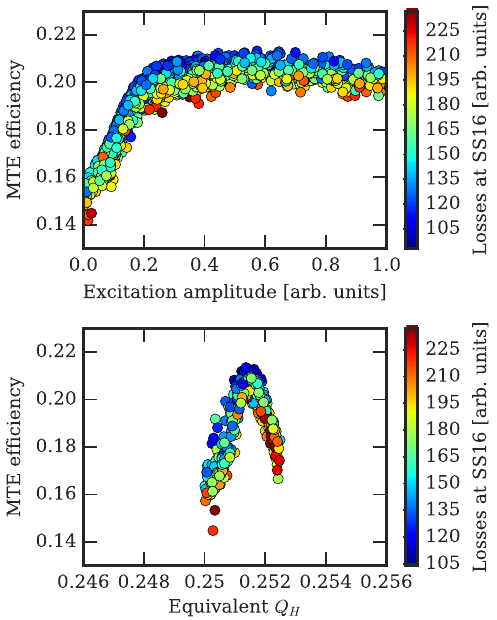
FIG. 14. Dependence of η on the timing (top) and duration MTE (bottom) of the excitation generated by the transverse damper. In both cases the scanned quantities are provided with respect to the SS16.FIG. 13. Dependence of η on the amplitude (top) and MTE nominal value used for MTE operation. The color scale provides frequency (bottom) of the excitation generated by the transverse the information on the extraction losses as measured by the BLM damper. The color scale provides the information on the extrac- in tion losses as measured by the BLM in